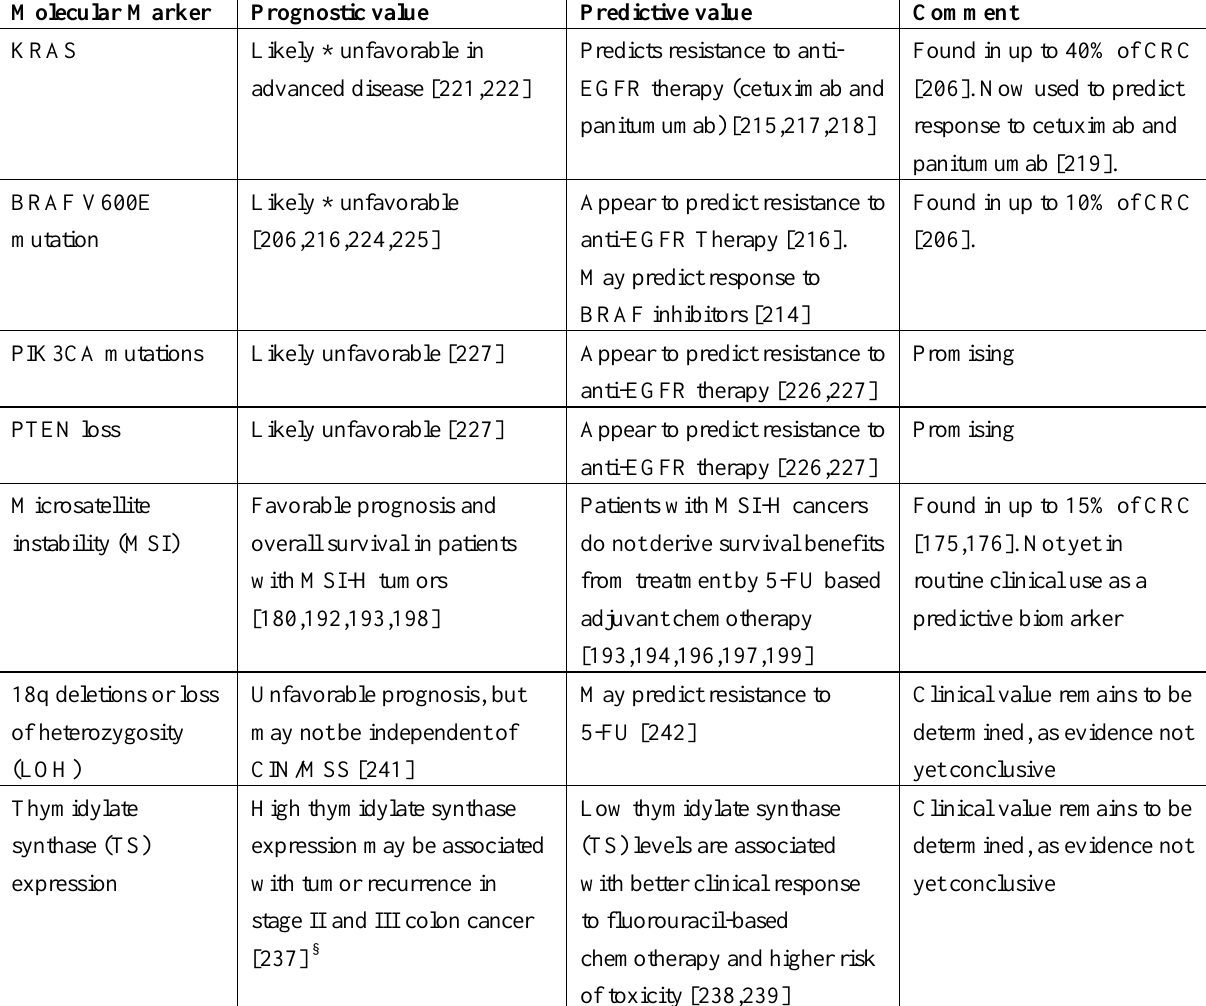
Table 3. Prognostic and Predictive molecular markers in colorectal